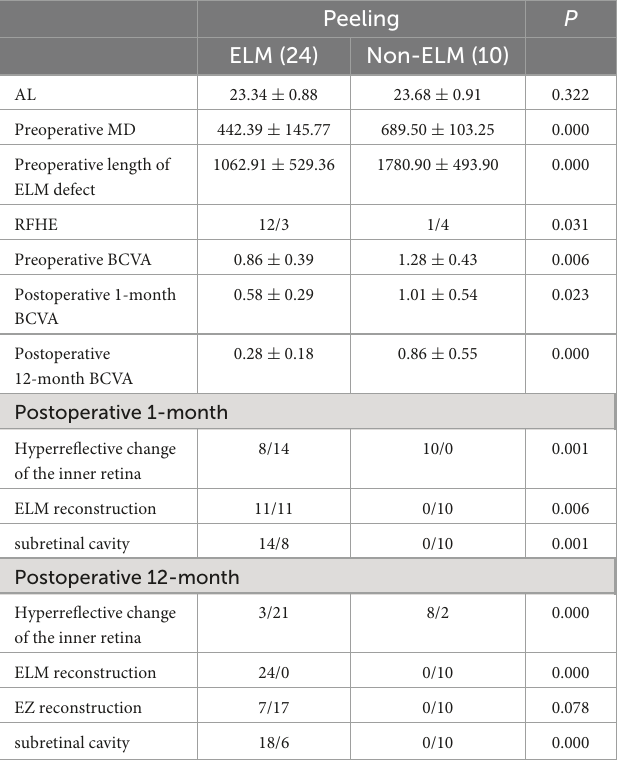
Kenawy (25) reported that RFs originated from vitreous cells and Muller cells after histological studies. In the patients in the ELM group, intraoperative RFs often appeared at the edge of the hole,